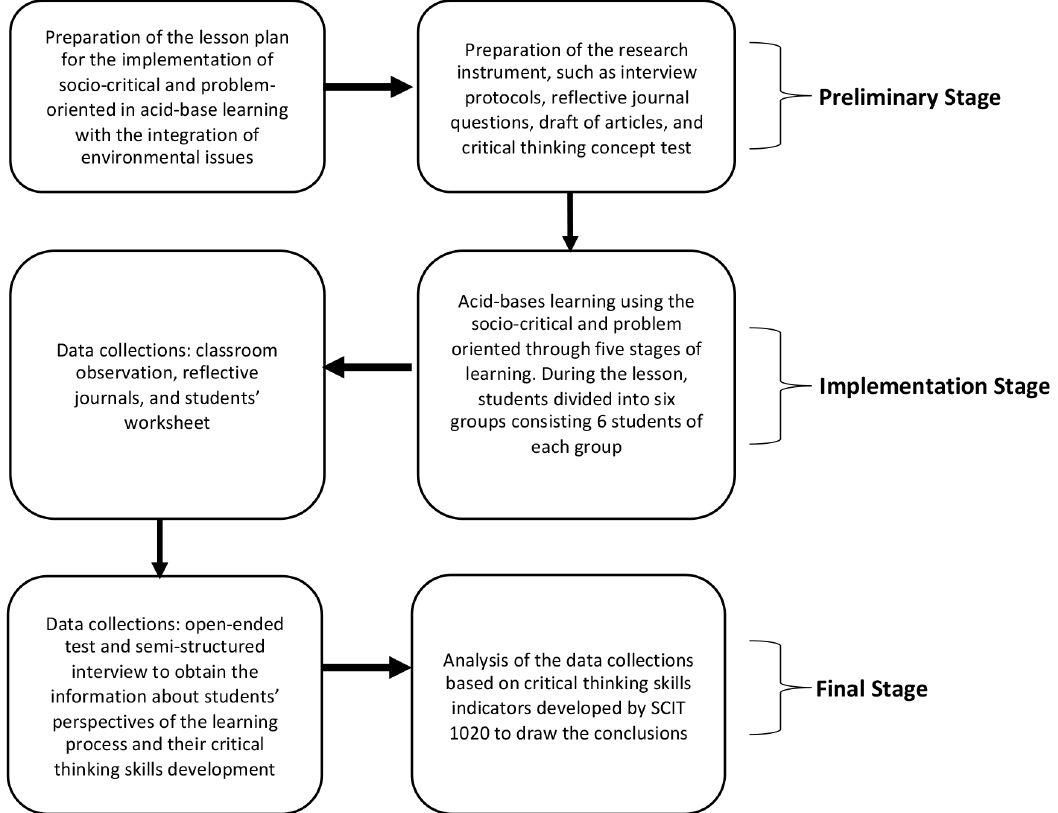
Figure 1. Research Flow and Data